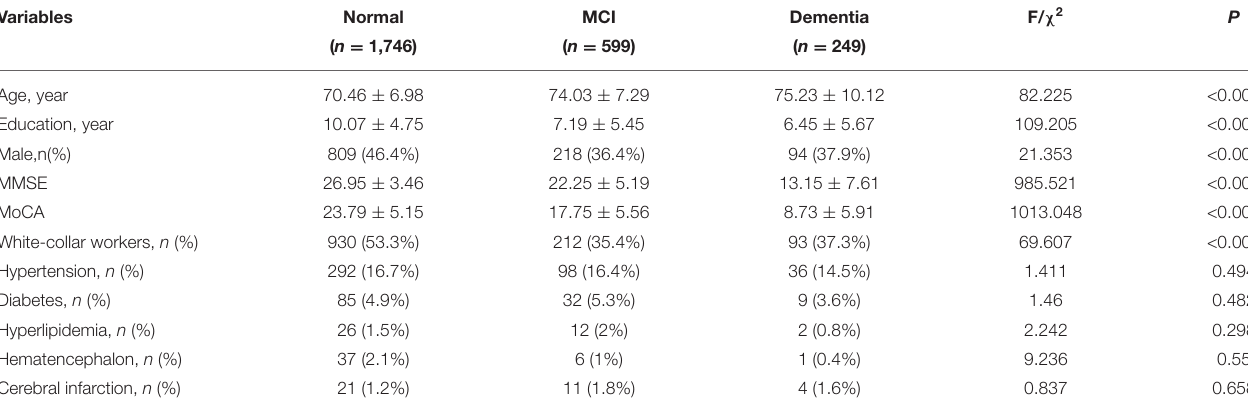
TABLE 2 | Demographic and clinical data of the participants. Variables